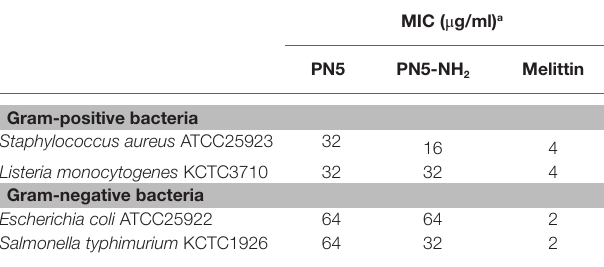
TABLE 3 | Antimicrobial activities of synthetic PN5 against foodborne bacteria.